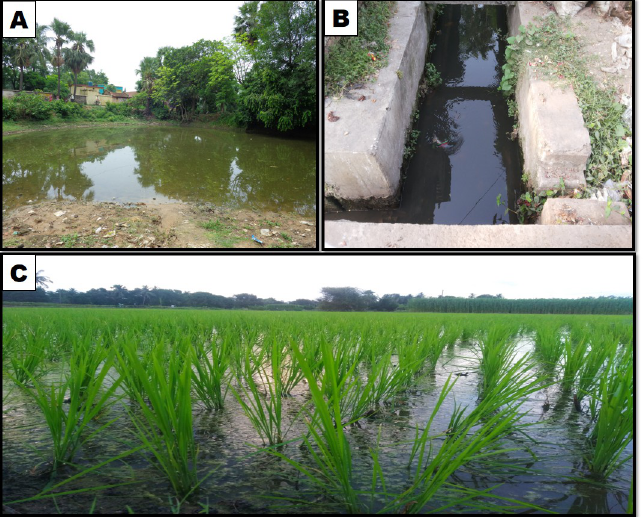
Fig 1. Different types of aquatic bodies surveyed during the study period. A: pond water, B: drain water, C: rice- field water.